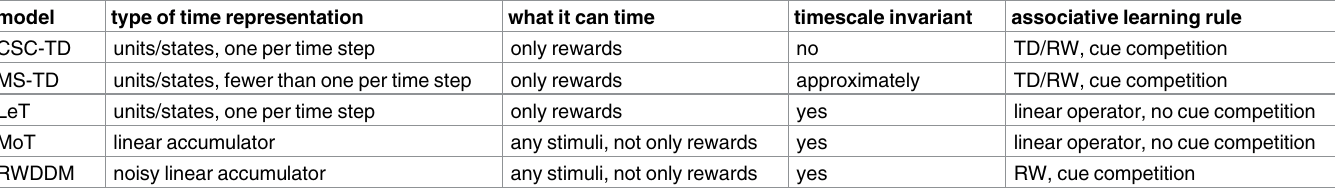
Table 1. Summaryof the main features of the